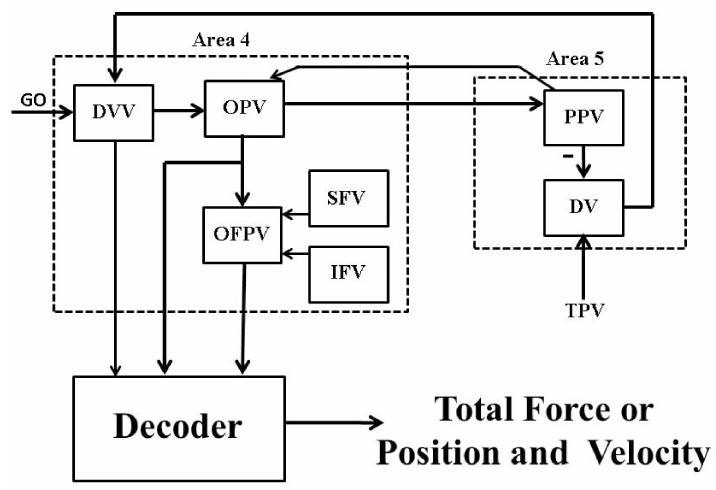
Figure 4. An open-loop BMI system